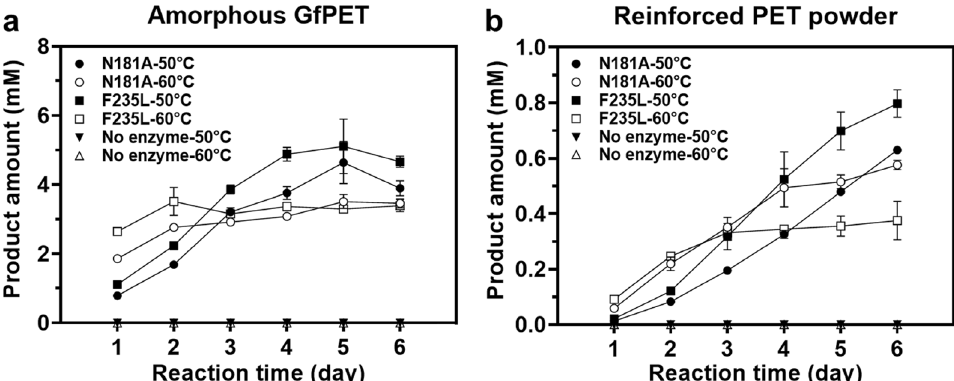
Fig. 5 Time‑dependent PET degradation activity of Ct PL‑DM variants. Hydrolytic reactions of the two variants against a GfPET film and b reinforced PET powder, and the blank controls without adding enzyme were conducted at 50 °C and 60 °C and sampled every 24 h to measure the total amounts of hydrolytic products (MHET and TPA). The results were displayed as average values